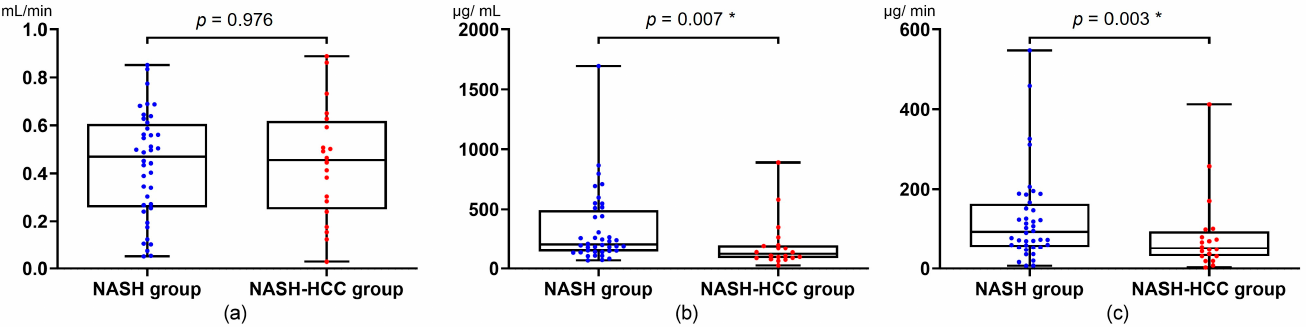
Figure 1. Salivary IgA levels: ( a ) saliva flow rate; ( b ) salivary IgA concentration; ( c ) salivary IgA flow rate. The presented values are medians (first quartile–third quartile), and the Mann–Whitney’s U test was used for statistical analysis (* p < 0.05). Each 99% confidence intervals were 0.972–0.980: ( a ), 0.005–0.010: ( b ) and 0.001–0.004: ( c ).